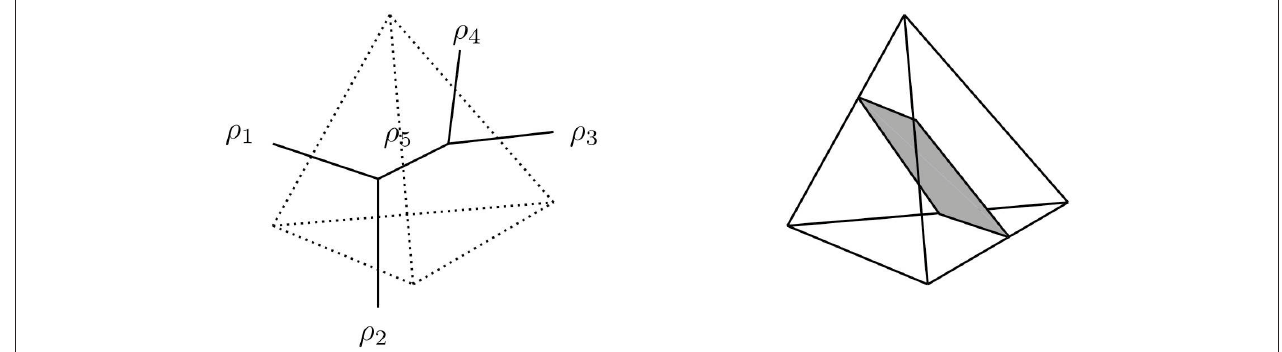
FIGURE 1 | (Left) A 4-valent intertwiner, dual to a tetrahedron, expanded in an orthonormal basis. The shape of a tetrahedron is not determined by the areas of its four triangles. (Right) The intermediate representation gives the area of a parallelogram in the center of the tetrahedron. Its corners are located on the center points of the edges of the tetrahedron according to the split of the